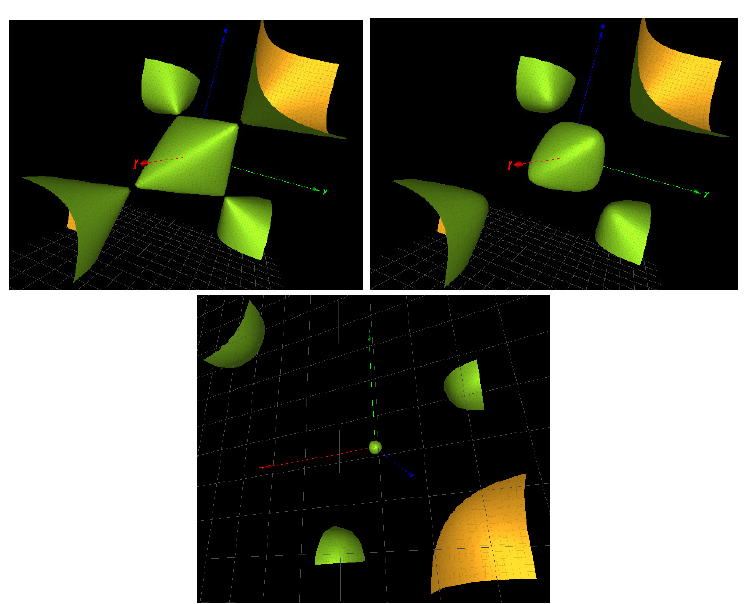
Figure 1. Top left : the Cayley cubic κ 4 ( x , y , z ) , Top right : the surface κ 2 ( x , y , z ) , Down , the surface κ d ( x , y , z ) with d = − 1 16